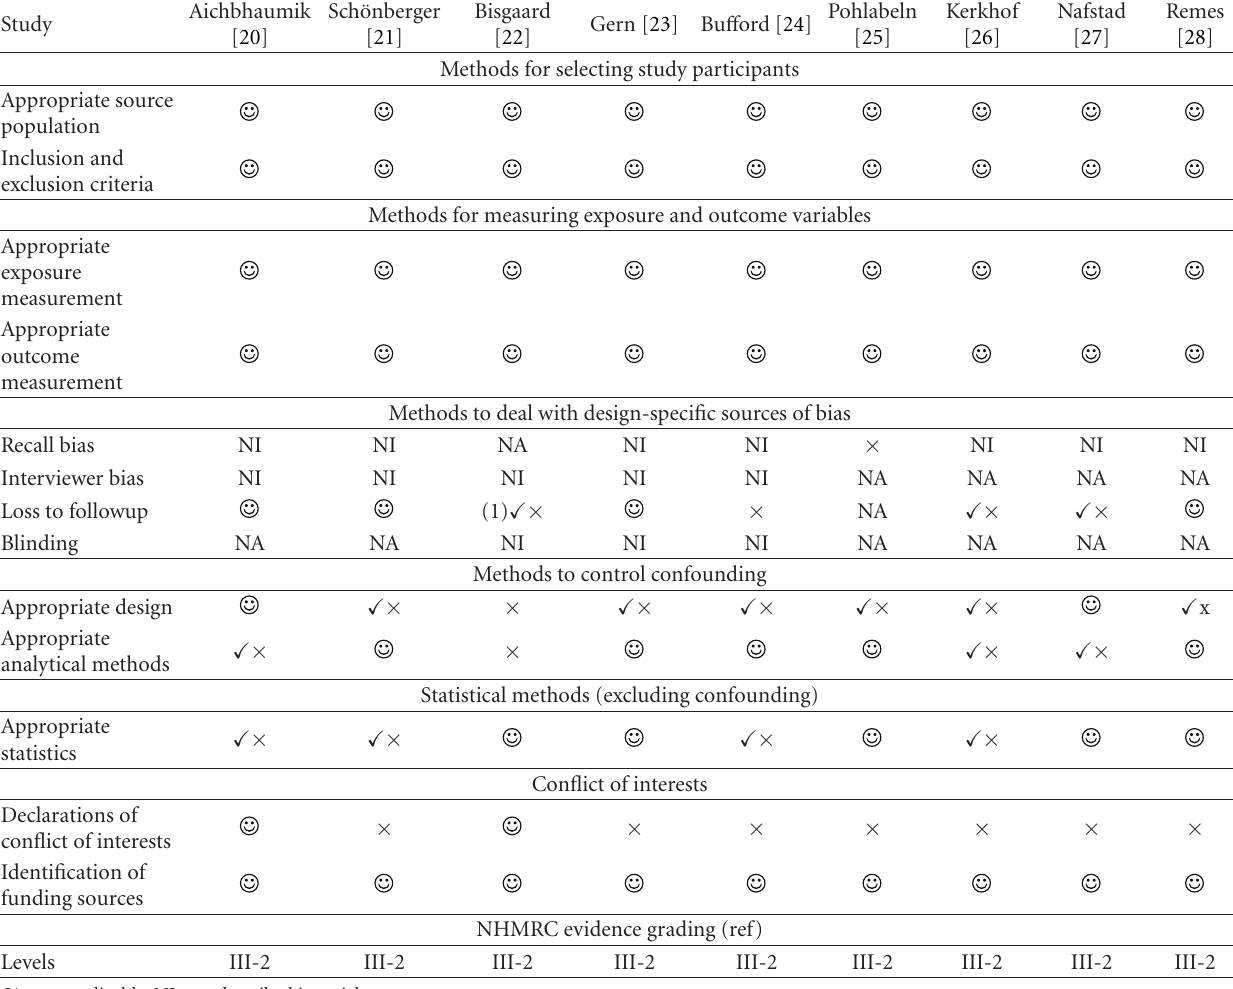
Table 2: Evaluating the role of bias in the included